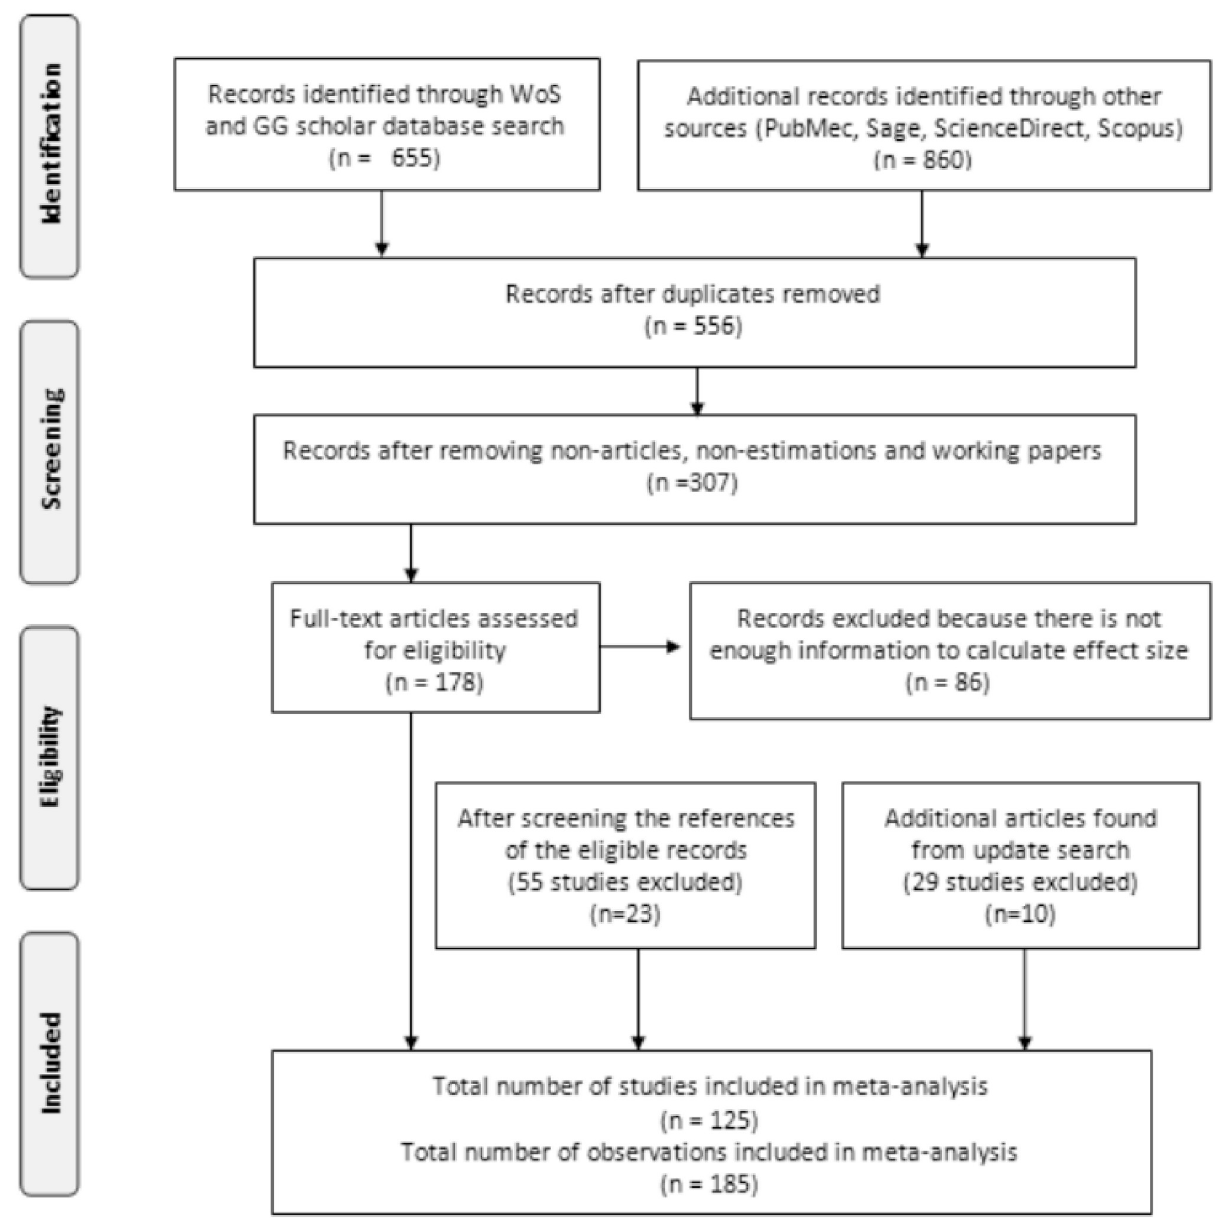
Fig 1. PRISMA flow diagram of data